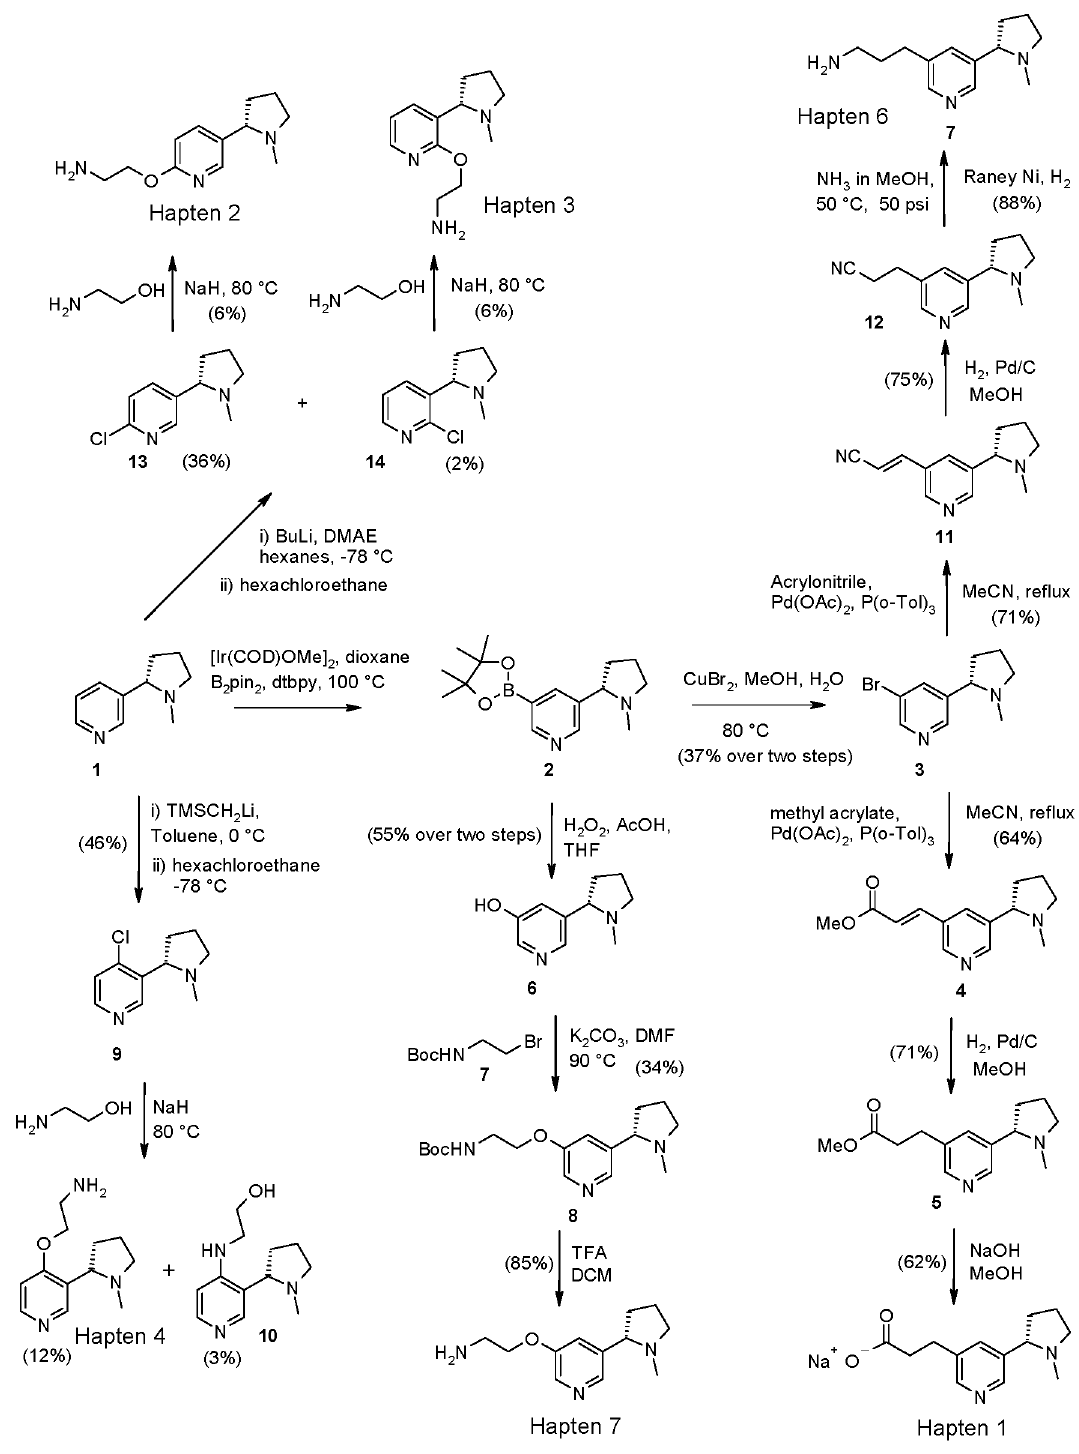
Figure 2. Synthesis of Haptens 1, 2, 3, 4, 6 and 7.